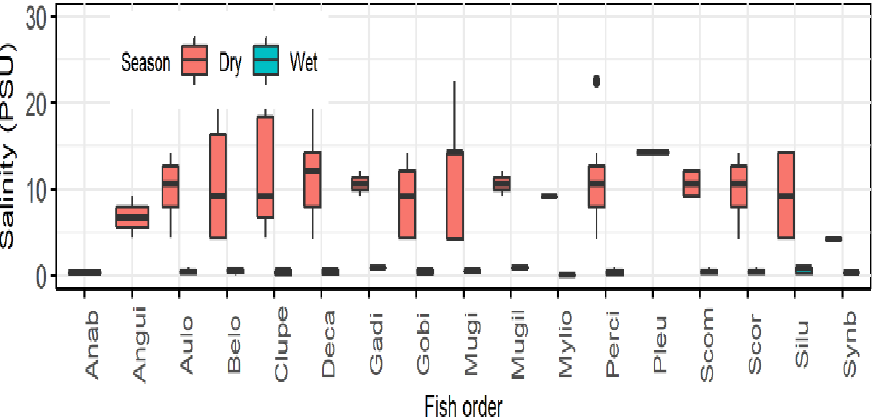
black spot represents the percentiles; the vertical part of the box body extending upward and downward represents the range of data distribution. Fish species from the orders Beloniformes, Clupeiformes, Decapoda, Gobiiformes, Mugiliformes and Siluriformes were found during the dry season when salinity was near to 18 psu (Figure 6). Fish species from the orders Anguiliformes, Aulopiformes, Gadi ‐ formes, Myliobatiformes, Perciformes, Pleuronectifomes, Scombriformes and Scorpaeni ‐ Figure 5. Fish orders availability with salinity variation. Note: the top, bottom and middle lines of Figure 5. Fish orders availability with salinity variation. Note: the top, bottom and middle lines of formes were also available during the dry season, but at that time salinity was compara ‐ the Box plot represent the upper quartile, the lower quartile and the median, respectively; the black the Box plot represent the upper quartile, the lower quartile and the median, respectively; the tively lower ( ≃ 11 psu). However, Anabantiformes and Synbranchiformes were available spot represents the percentiles; the vertical part of the box body extending upward and downward mostly in fresh water during the wet season when the salinity was near to 0 psu. represents the range of data distribution.